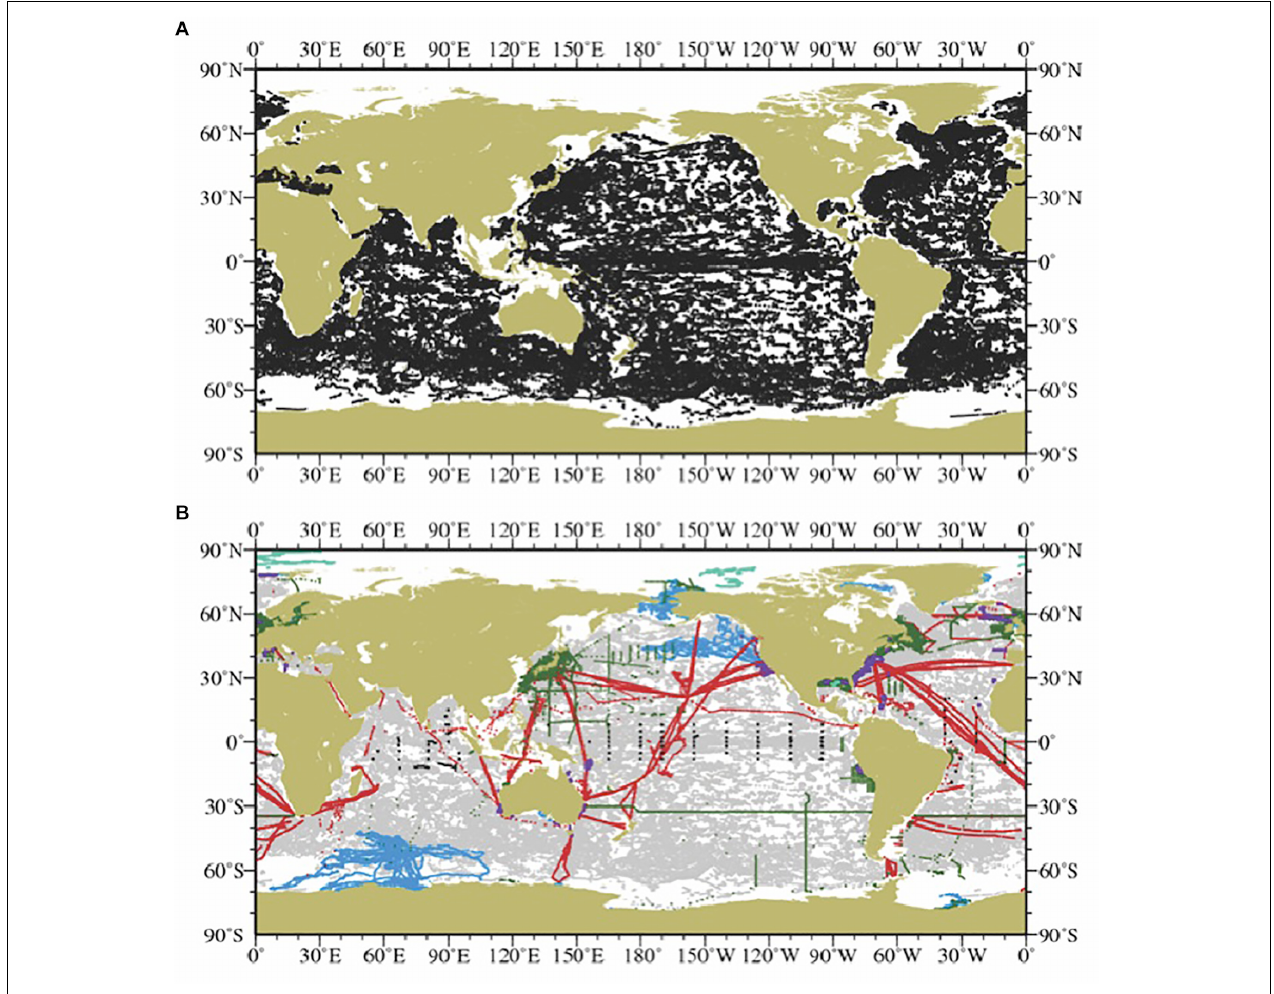
FIGURE 3 | Temperature profile locations in 2017 from (A) Argo floats and (B) ship-based bottle/Conductivity-Temperature-Depth (CTD) casts (dark green), Expendable Bathythermographs (XBT) drops (red), tropical moored buoy daily means (black), glider cycles (purple), instrumented pinniped dives (blue) and ice-tethered profilers (light green) [Argo cycles in background (gray) for